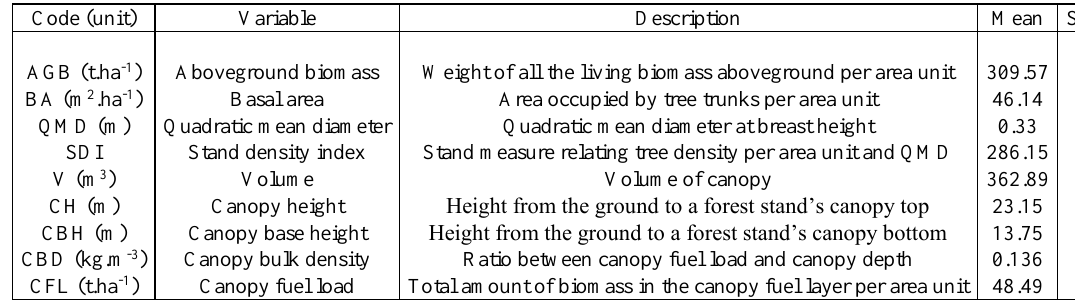
Table 1. Summary of forest structure and canopy fuel variables